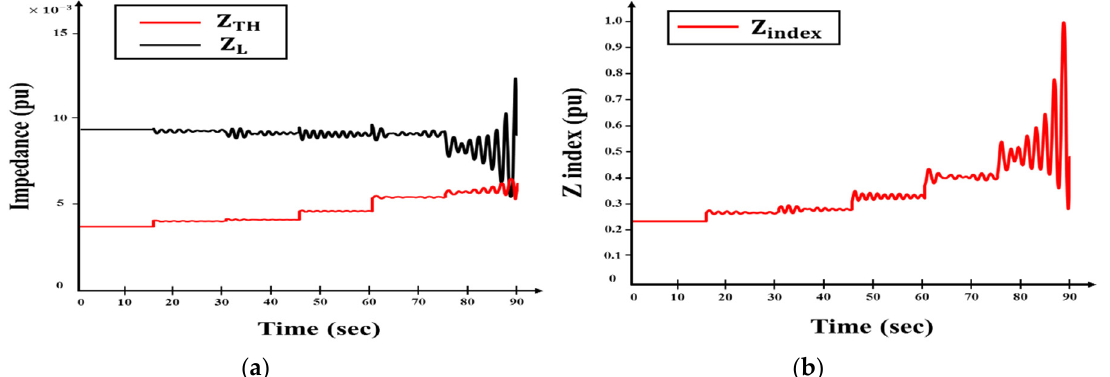
Figure 16. Progress of the index in case 2. ( a ) Z Th and Z L . ( b ) Z index.